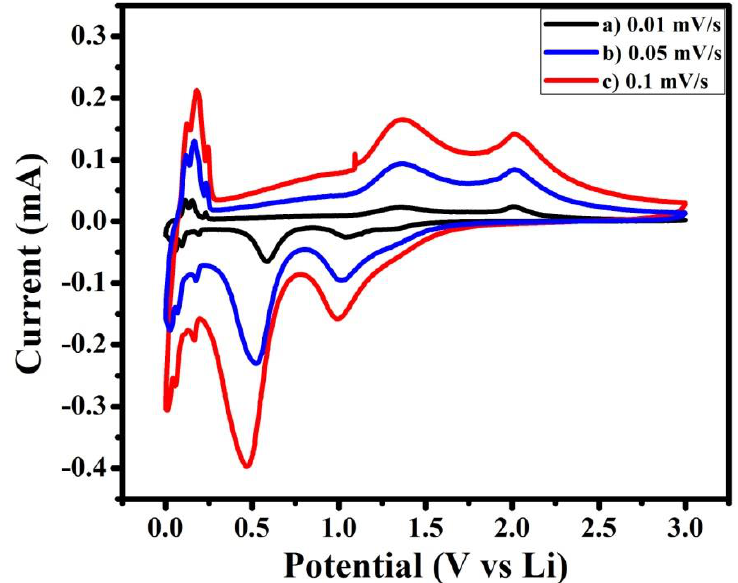
Figure 6. Cyclic voltammetry curves of NMO at different scan rates of (a) 0.01, (b) 0.05, and (c) 0.1 mV/s.